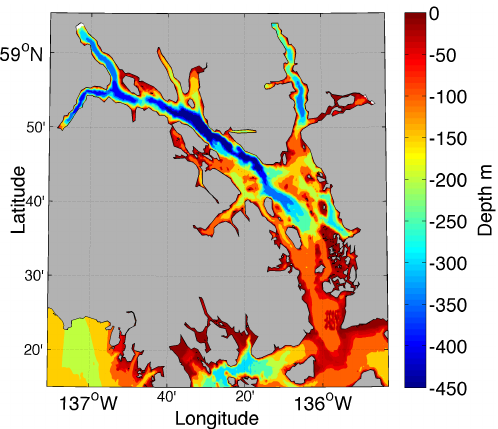
Figure 2. Bathymetric map of Glacier